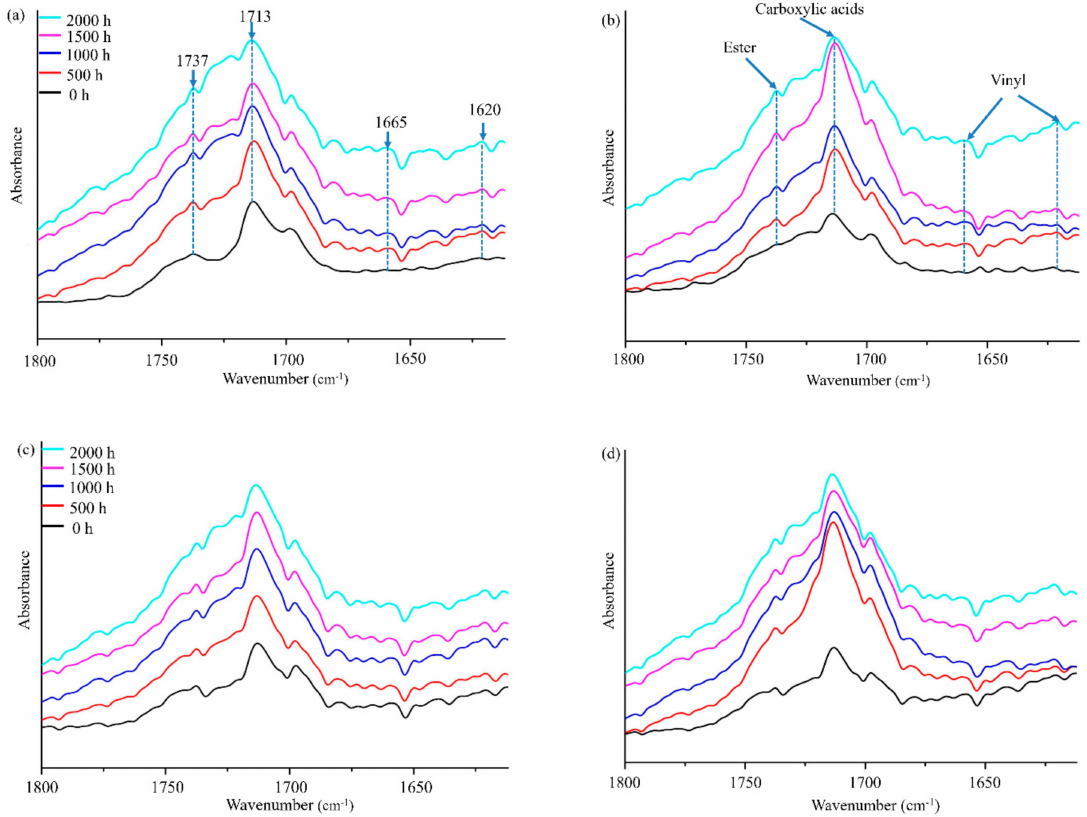
Figure 5. FTIR spectra of coextruded WPC composites before and after weathering: ( a ) WPC-U;( b ) WPC-B; ( c ) WPC-B-U; and, ( d )